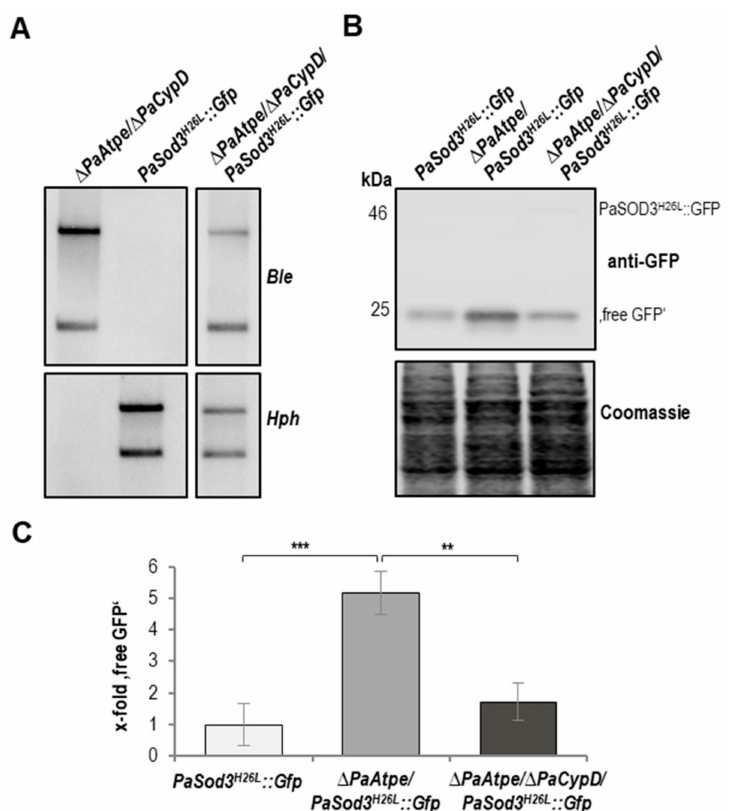
Figure 7. Mitophagy induction in ∆ PaAtpe is dependent of PaCYPD. ( A ) Southern blot anal- ysis verifies the newly generated double mutant ∆ PaAtpe/ ∆ PaCypD/PaSod3 H26L ::Gfp by the phleomycin ( Ble ) and hygromycin ( Hph ) resistance genes. ( B ) Monitoring mitophagy by west- ern blot analysis of total protein extract from PaSod3 H26L ::Gfp , ∆ PaAtpe/PaSod3 H26L ::Gfp and ∆ PaAtpe/ ∆ PaCypD/PaSod3 H26L ::Gfp cultures with a GFP-antibody (each 4 biological replicates). ( C ) Quantification of “free GFP” protein levels from (B) normalized to the Coomassie stained gel. Protein level in PaSod3 H26L ::Gfp cultures were set to 1. Error bars correspond to the standard deviation and p -values were determined by two-tailed Student’s t test. ** p < 0.01, *** p <